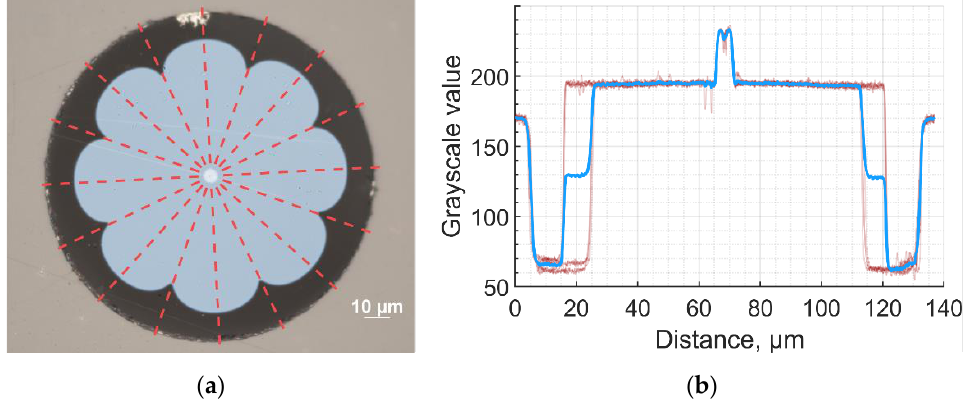
Figure 2. ( a ) Double-clad EYDF cross section; ( b ) the resulting line profiles in red with their average shown in blue.